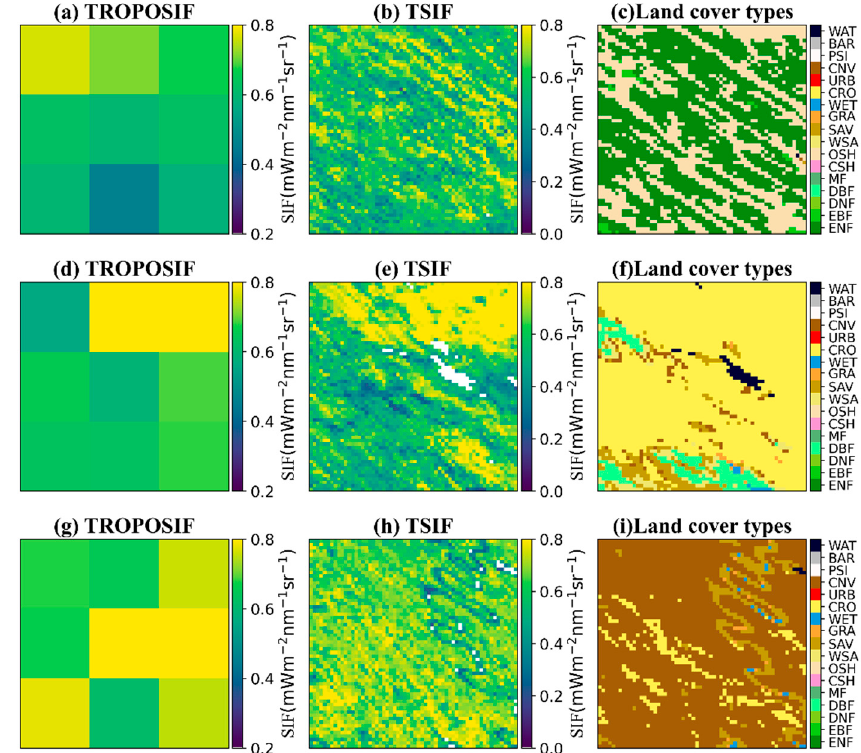
Figure 10. The spatial details of the downscaled TSIF; ( a , d , g ) are 3 × 3 grids from TROPOSIF; ( b , e , h ) are 60 × 60 grids of TSIF corresponding to ( a , d , g ); and ( c , f , i ) are 60 × 60 grids from MCD12Q1 land cover (2019). TROPOSIF and TSIF data correspond to MODI Grid Tile H27V05 and the date of the data is 28 July 2019.